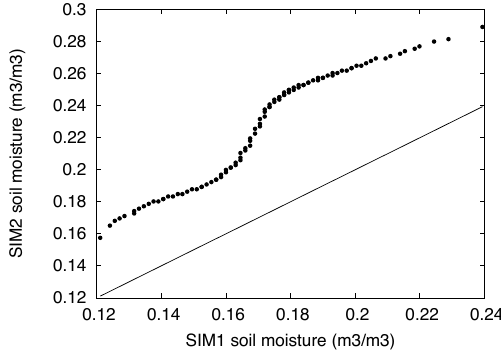
Figure 3. A comparison of the cumulative distribution func- tions (CDFs) from SIM1 and SIM2